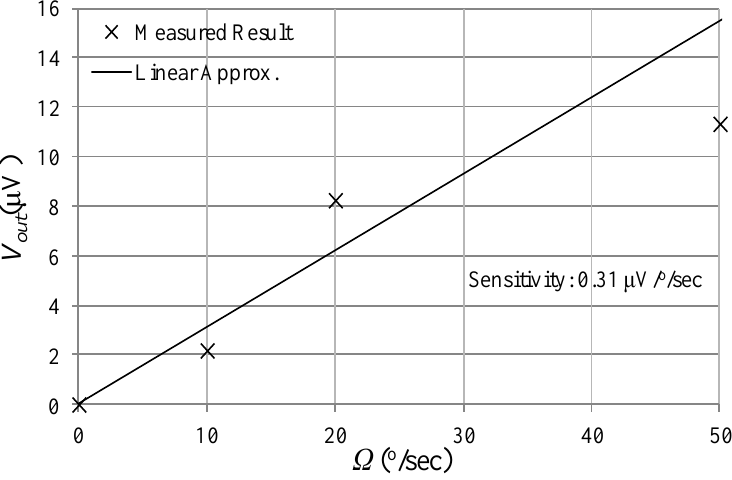
Figure 16. Measured angular rate response, and a linear